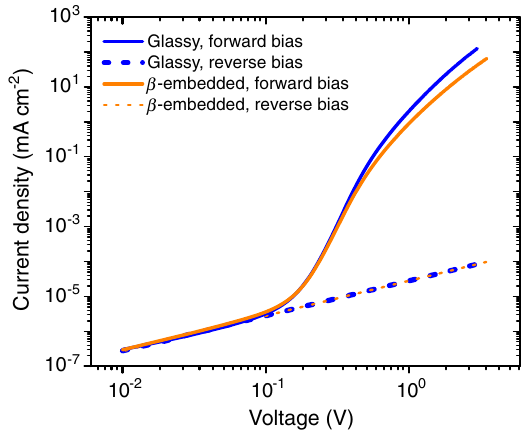
FIG. 10. Simulated steady-state dark current density – voltage curves for glassy (blue) and β -phase embedded (orange) PFO hole-only devices. The model reproduces the slight reduction in forward-bias current density that is observed experimentally, indicative of a lower steady-state μ for β -phase embedded than h for purely glassy hole-only devices.